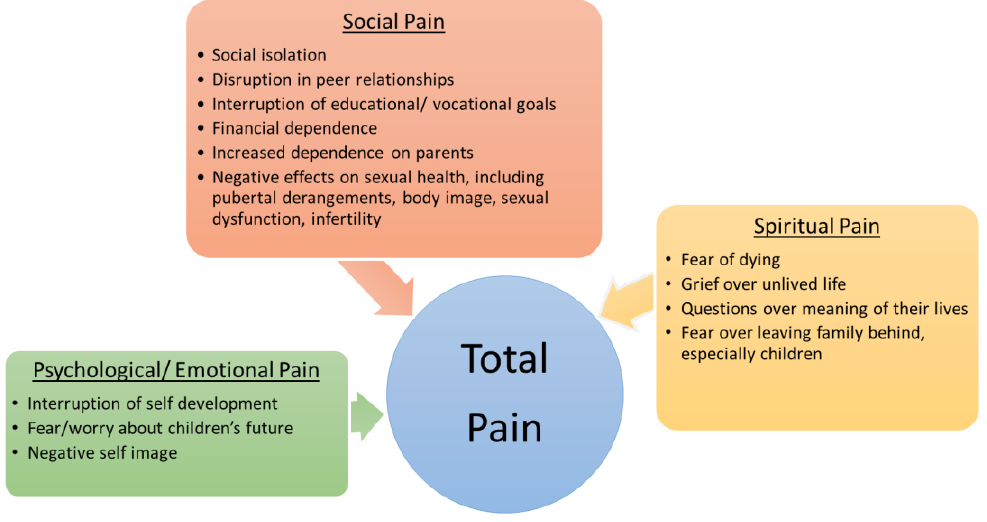
Figure 2. Psychological/emotional, social, and spiritual aspects of total pain in AYAs. I.